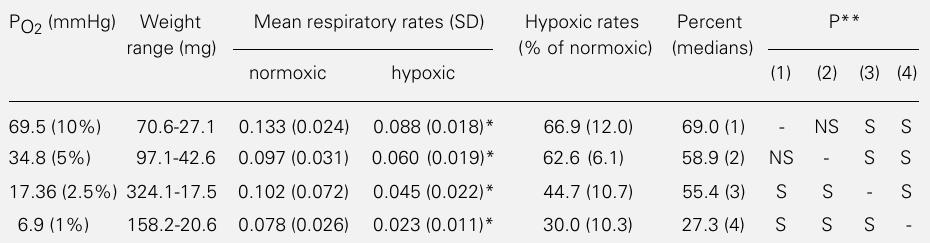
Table 1 - Respiratory rates (µl O 2 mg wet weight -1 h -1 ) and oxygen tension in an enteropneust, Glossobalanus crozieri . P O 2 (normoxia): 146 mmHg. Sea water: 34 S. Temperature: 25 o C. N (per series): 6. *P<0.05 compared to normoxia (paired sample t -test); **Wilcoxon matched-pair test. S = Significant at P £ 0.05; NS =